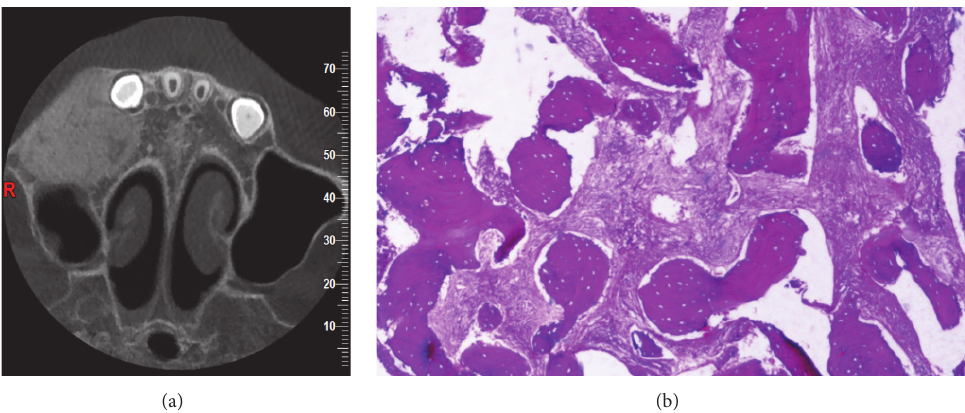
Figure 3: (a) Figure showing CBCT scan: axial section showing typical granular trabecular pattern and bicortical expansion with more than half of maxillary sinus involvement in relation to the maxillary right back tooth region. (b) Figure showing histological picture showing immature woven bone with fibrous